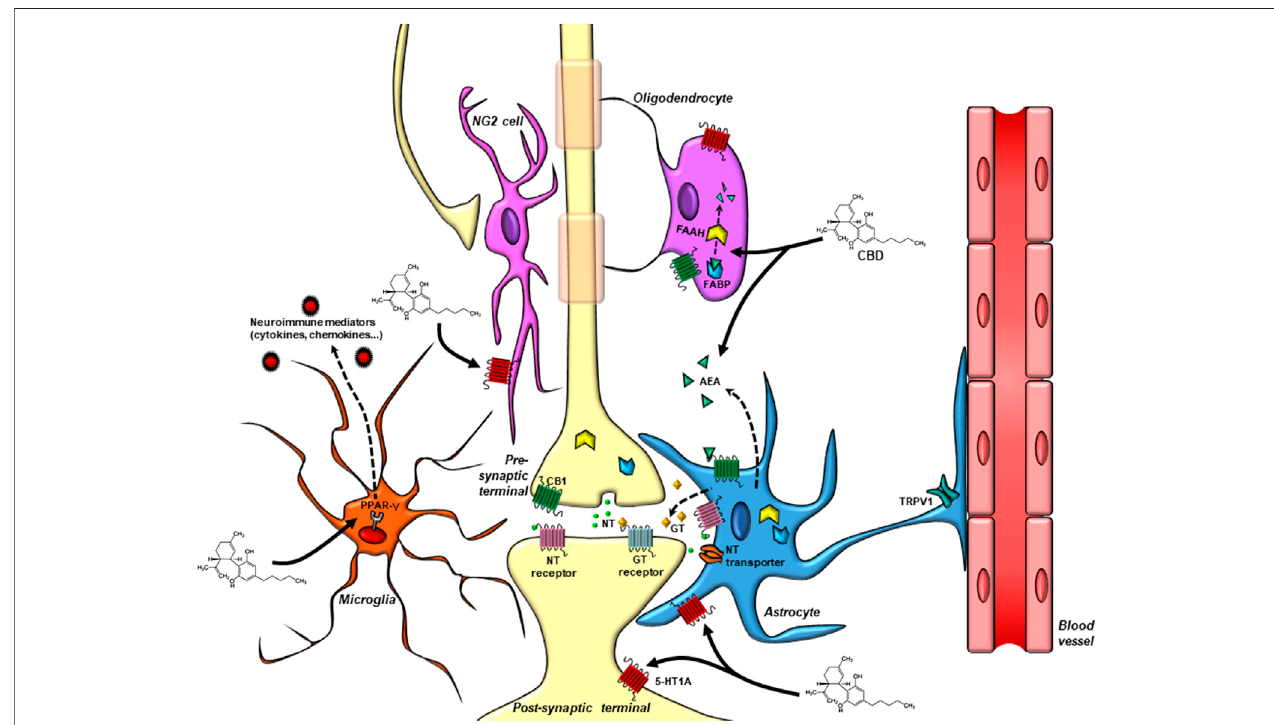
FIGURE2| DrugtargetsforCBDinthe “ pentapartite ” synapse.Glialcellsdisplayimportantrolesinsynapticsignalingandmaintenance.Theyareincloseproximity to the pre and postsynaptic terminals, express neurotransmitter receptors, control the content ofneurotransmitters in the synaptic cleftvia the expression oftransporter proteins, and modulate synaptic activity by releasing gliotransmitters that act in neuronal receptors. Astrocytes also regulate the neurovascular coupling and the blood- brain barrier permeability. Microglial cells control the maintenance of synaptic connections, eliminate unwanted synaptic contacts and release neuroimmune modulators that regulate neuronal function. NG2 cells receive direct synaptic contacts from glutamatergic and GABAergic neurons. Oligodendrocytes maintain the myelin sheets necessary for proper impulse propagation in neurons. In this complex cellular dynamic, CBD targets are found not only in neurons, but also in glial cells. Astrocytes and microglial cells can synthetase and release AEA. Endocannabinoid levels are regulated by FABP and FAAH present both in neuronal and glial cells. Cannabinoid, TRPV1, PPAR- γ , and the serotonin 5-HT1A receptors, proposed to participate in CBD actions, are also present in glial cells and neurons. CBD